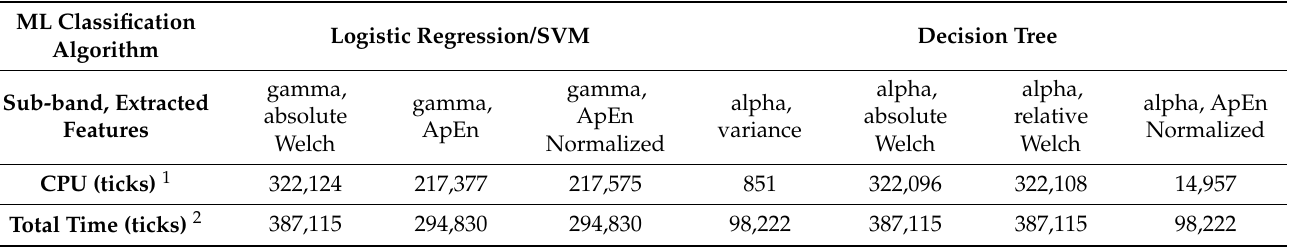
Table 7. The Energest module time results of each feature in our scheme.